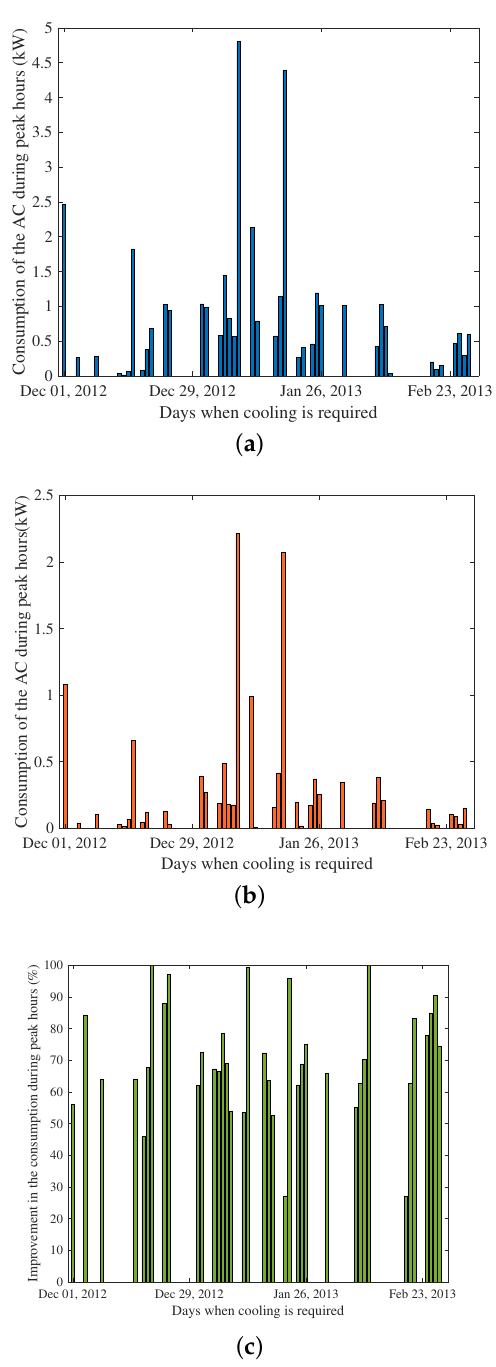
Figure 10. Power consumption of the AC during peak hours with and without optimum pre-cooling. ( a ) No pre-cooling. ( b ) Optimum pre-cooling. ( c )